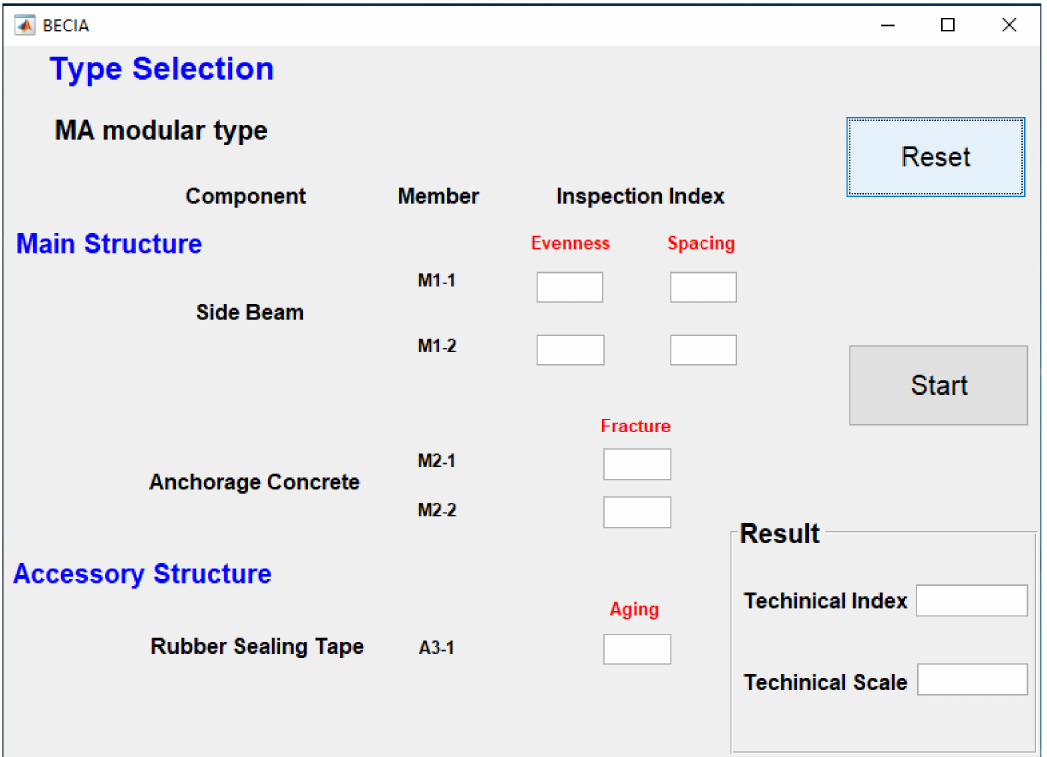
Figure 3. User interface of BECIA